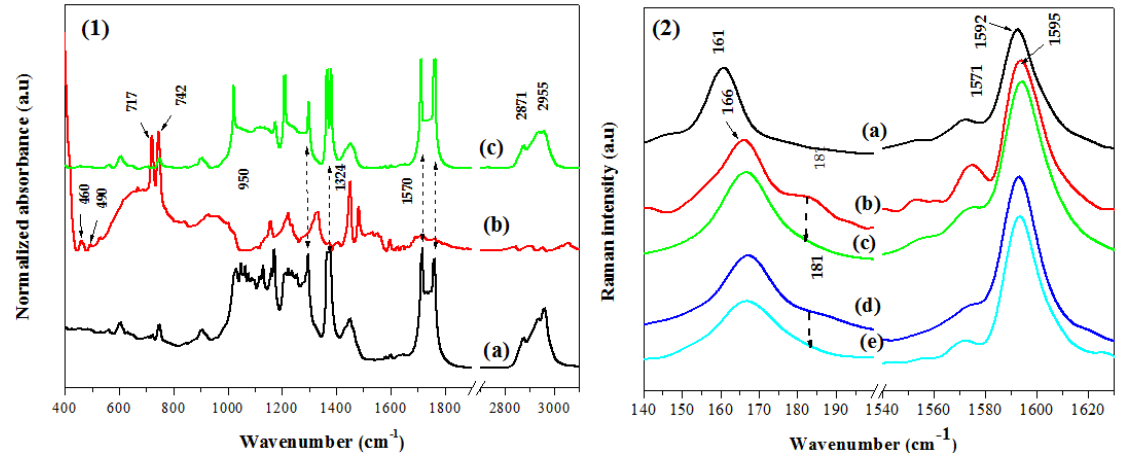
Figure 3. ( 1 ) Infrared spectra of the OVK/SWCNT composite dispersed in a chloroform solvent ( a ) and a chlorobenzene solvent ( b ) not annealed and ( c ) annealed at 333 K. ( 2 ) Raman radial and tangential modes: ( a ) SWCNTs; OVK/SWCNT in chloroform in the not-annealed ( b ) and annealed ( c ) states; OVK/SWCNT in chlorobenzene in the not-annealed ( d ) and annealed ( e ) states.